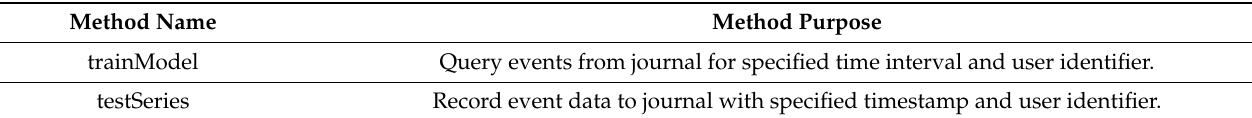
Table A10. Methods of IUserActivityJournal interface.